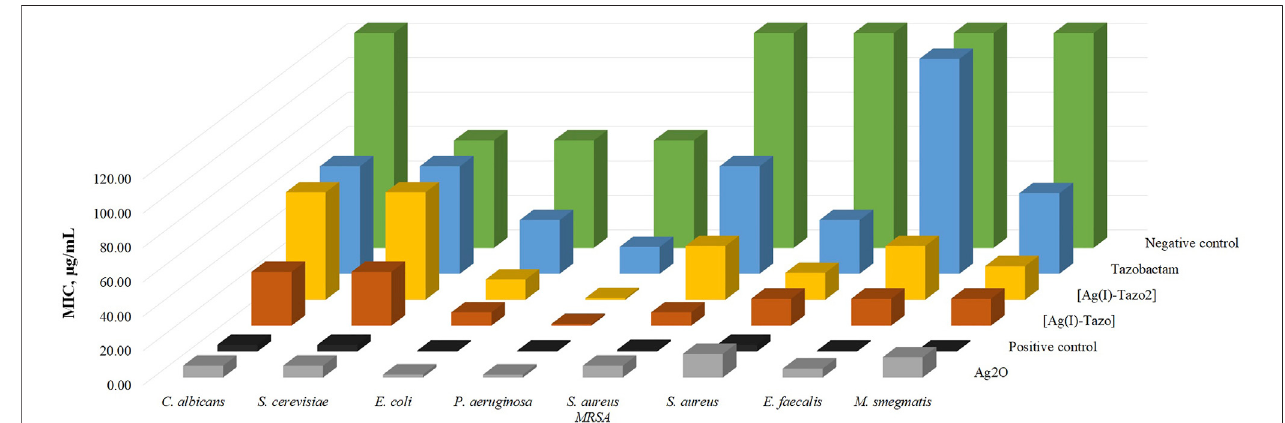
FIGURE 10 | Minimum inhibitory concentration values (MIC, µg/ml) of the synthesized compounds {[Ag(I)-Tazo] and [Ag(I)-Tazo 2 ]} and the starting materials for Candida albicans and Saccharomyces cerevisiae (yeasts), Escherichia coli and Pseudomonas aeruginosa (Gram-negative bacteria) and Staphylococcus aureus , Enterococcus faecalis and Mycobacterium smegmatis (Gram-positive bacteria) after 24 h for bacteria and 48 h for yeasts. DMSO was used as negative control and nystatin, nor fl oxacin and vancomycin were used as positive controls for yeasts, Gram-negative and Gram-positive bacteria, respectively.